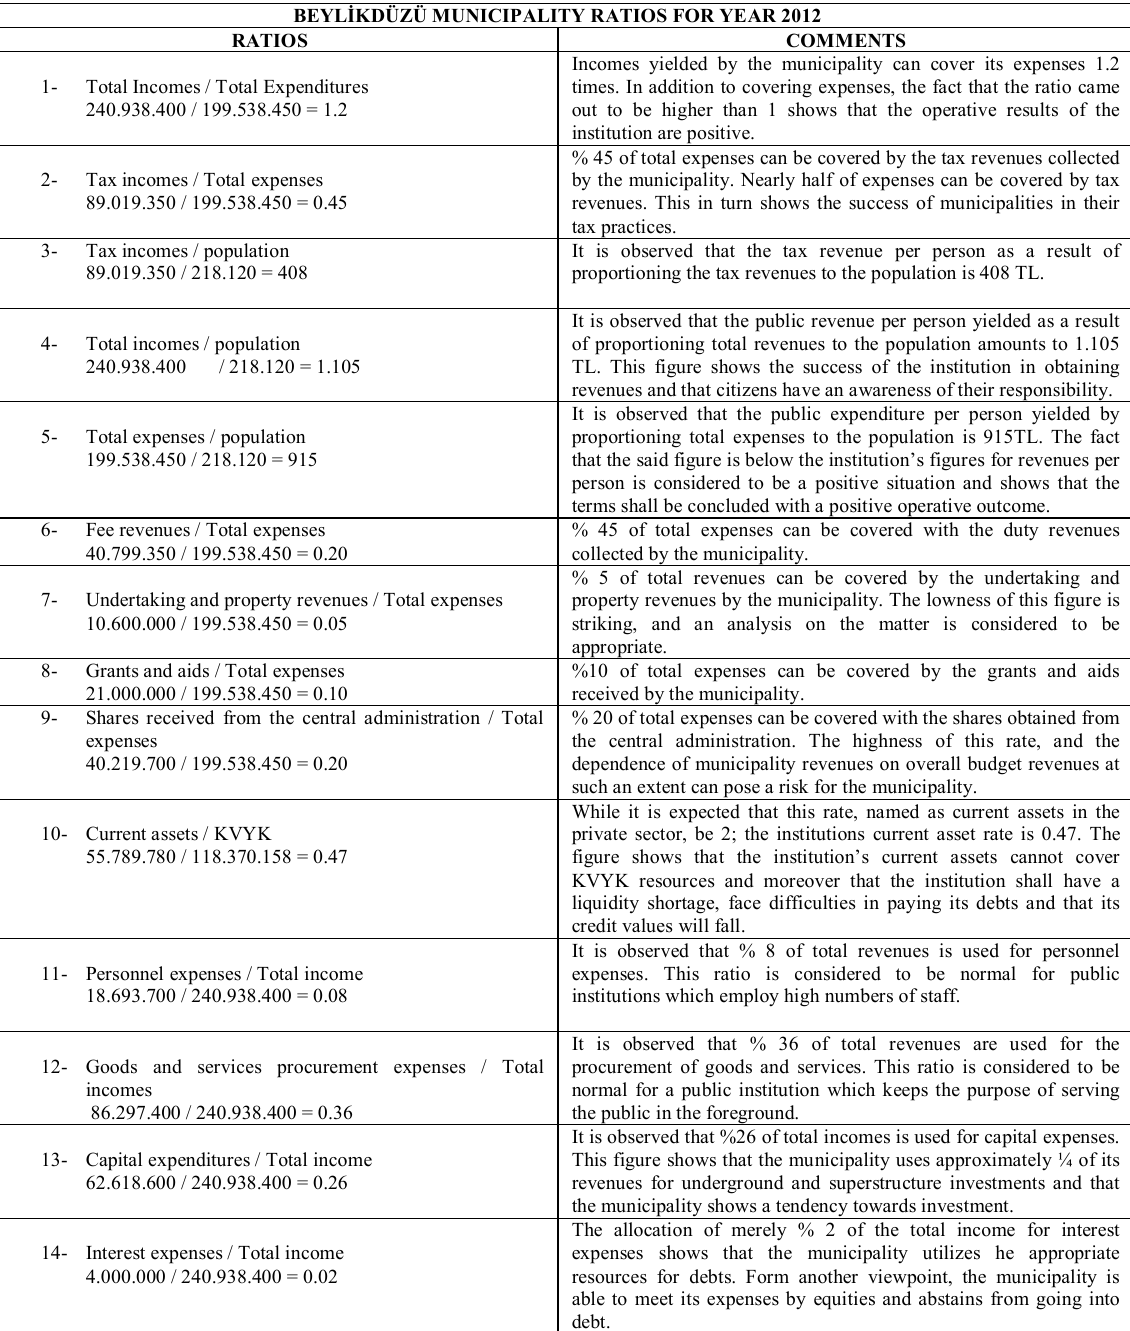
Table 3: Beylikdüzü Municipality Year 2012 Ratios BEYLİKDÜZÜ MUNICIPALITY RATIOS FOR YEAR 2012